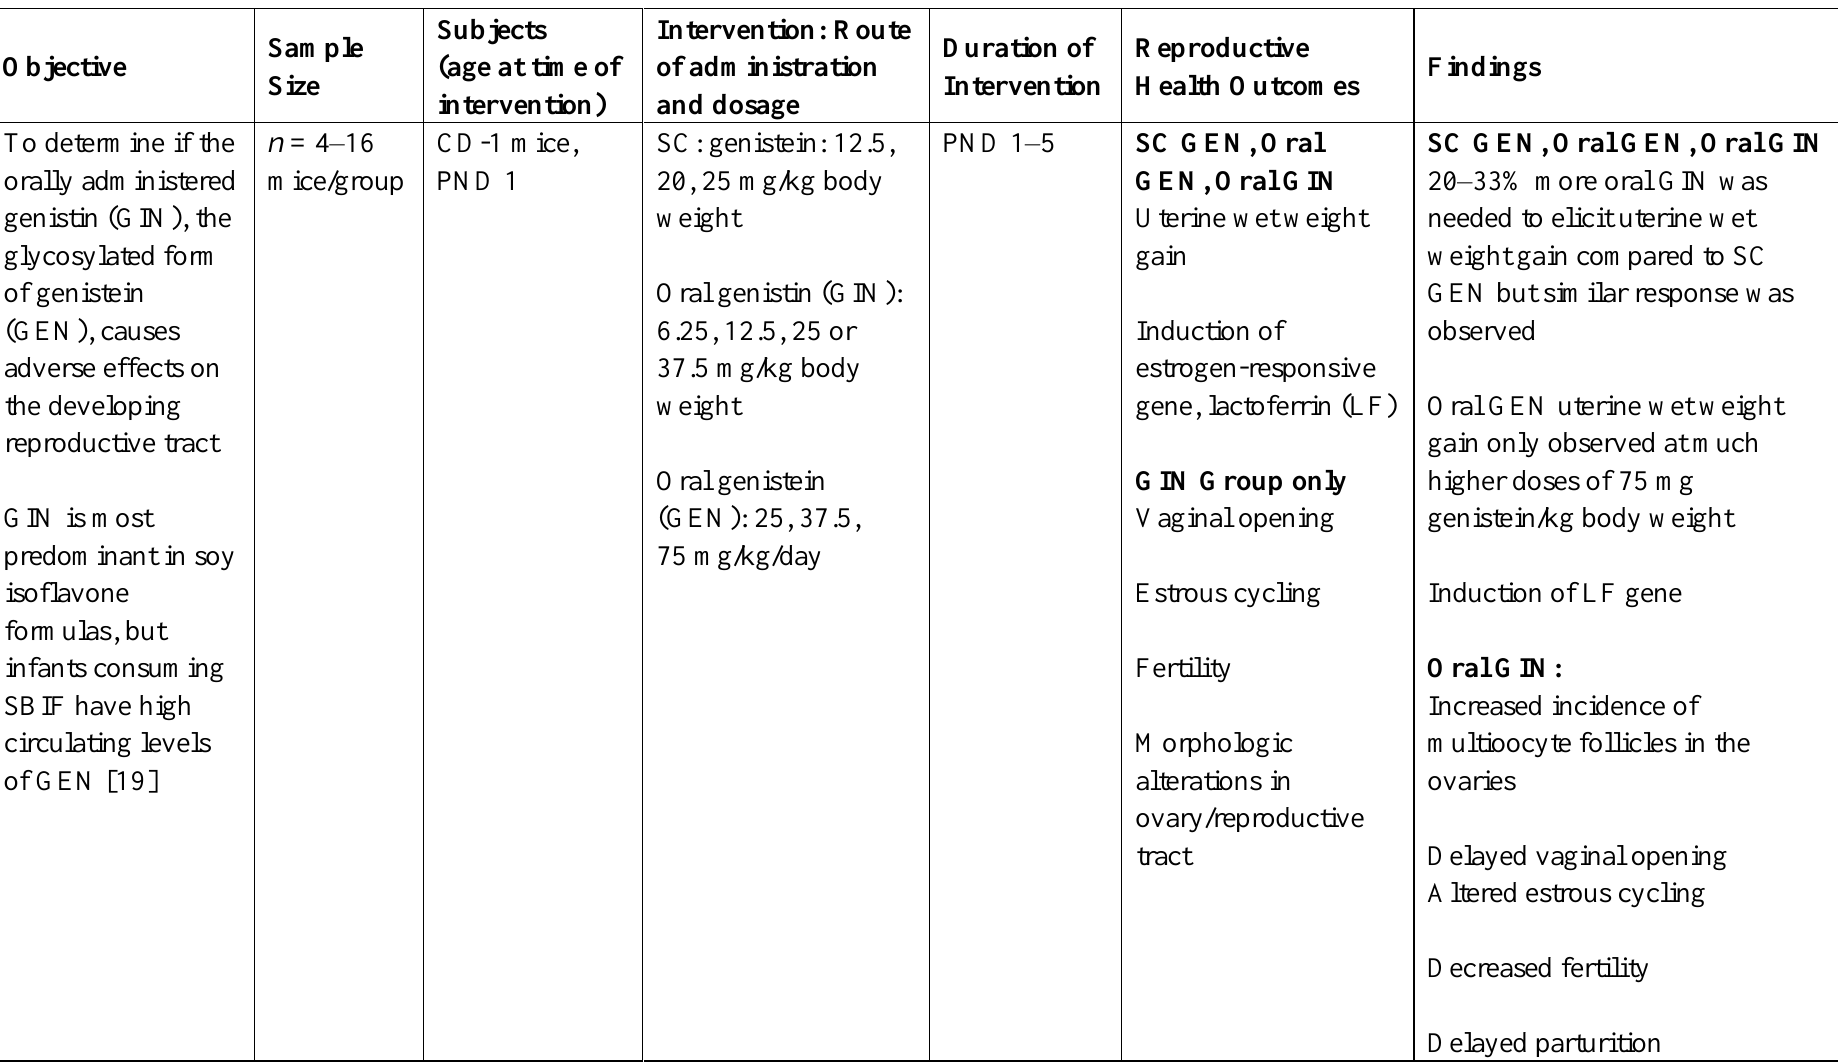
Table 5. Studies in female animal models examining the effects of soy isoflavone exposure during early